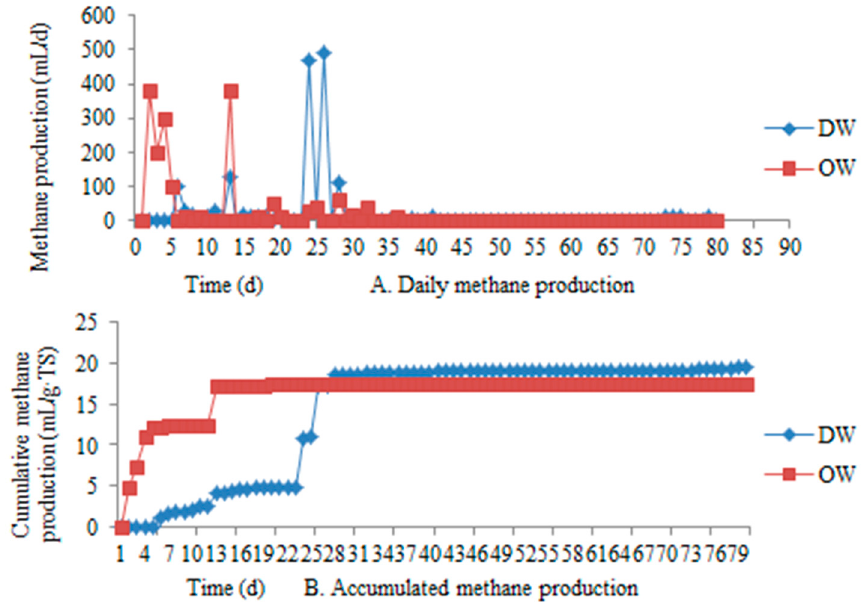
Figure 10. The change in methane production under different conditions.